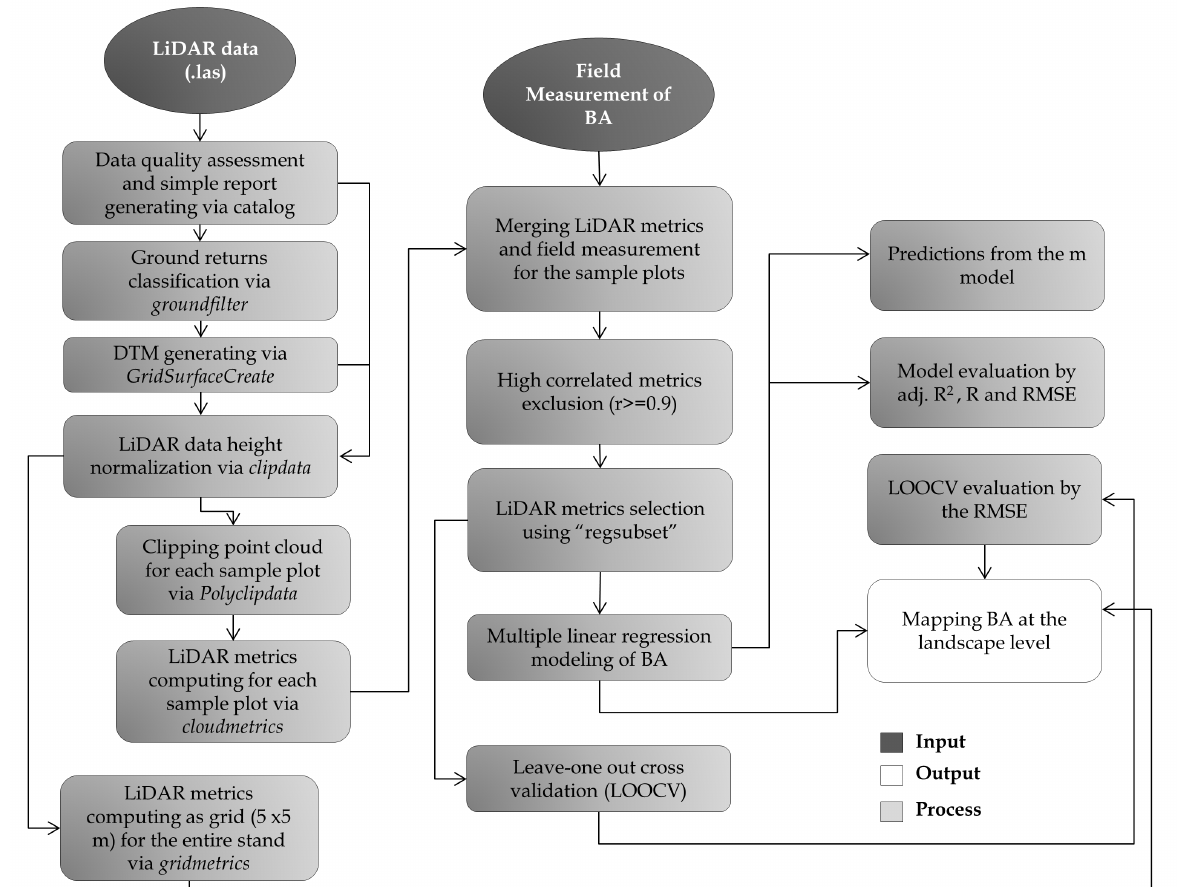
Figure 2 - LiDAR flight